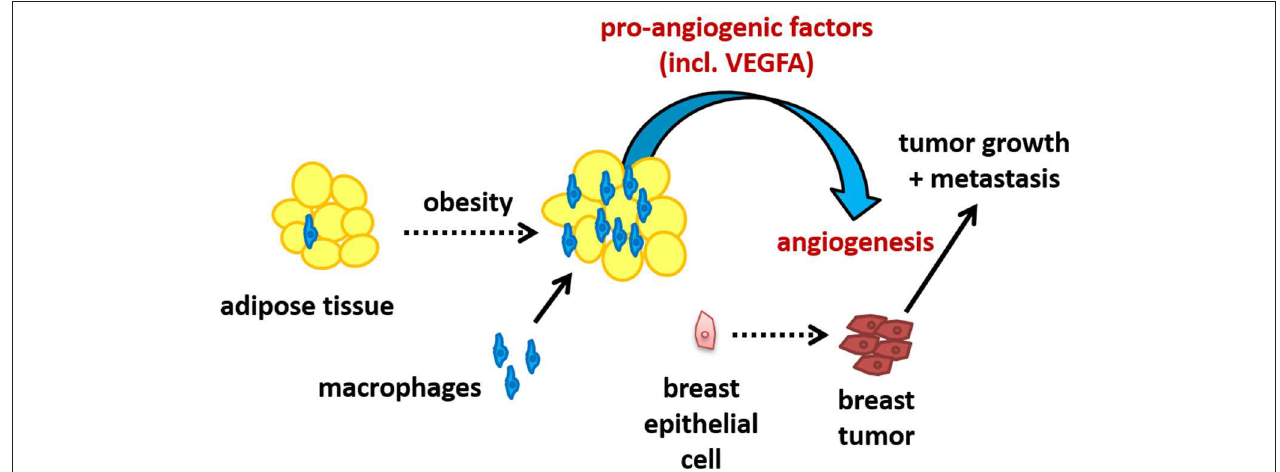
FIGURE 6 | Schematic illustrating the potential of the adipocyte-macrophage interaction in obese breast adipose tissue to promote angiogenesis and thus metastasis.